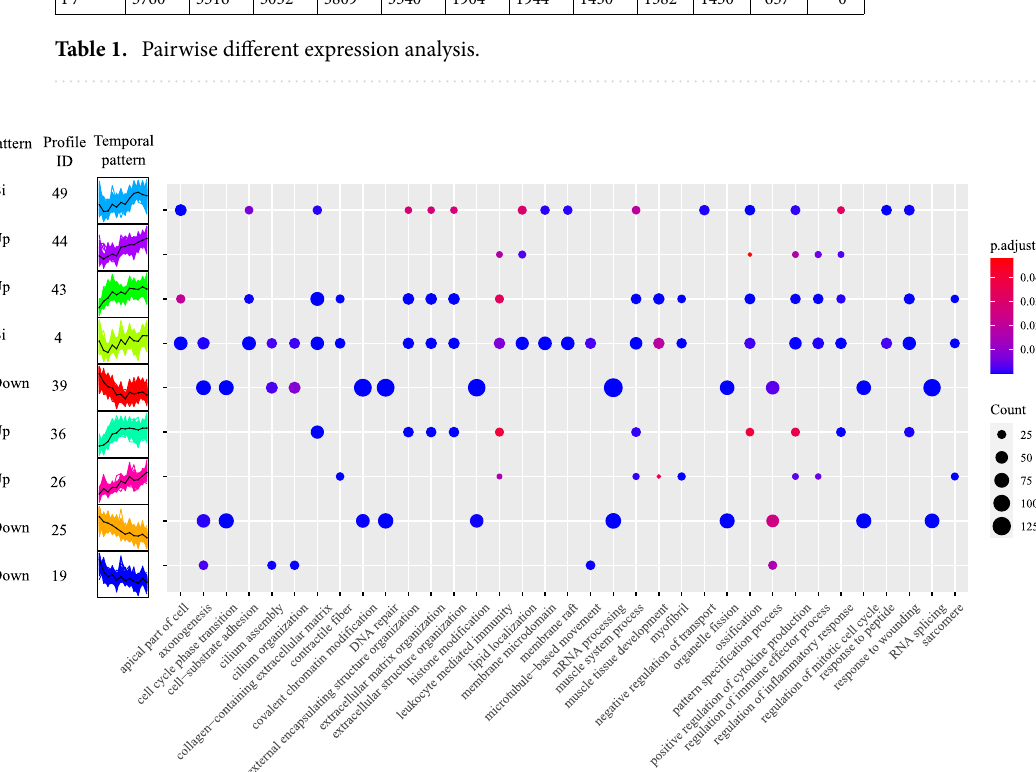
Figure 2. Temporal expression patterns of all the DEGs and their GO enrichment result. The left panel showed nine statistically significant Profiles ( p < 0.05) temporal expression pattern, assigned into three expression pattern, namely Bi, Up, Down. The right panel showed each profile GO enrichment result. Full enrichment results can be found in Supplementary Data